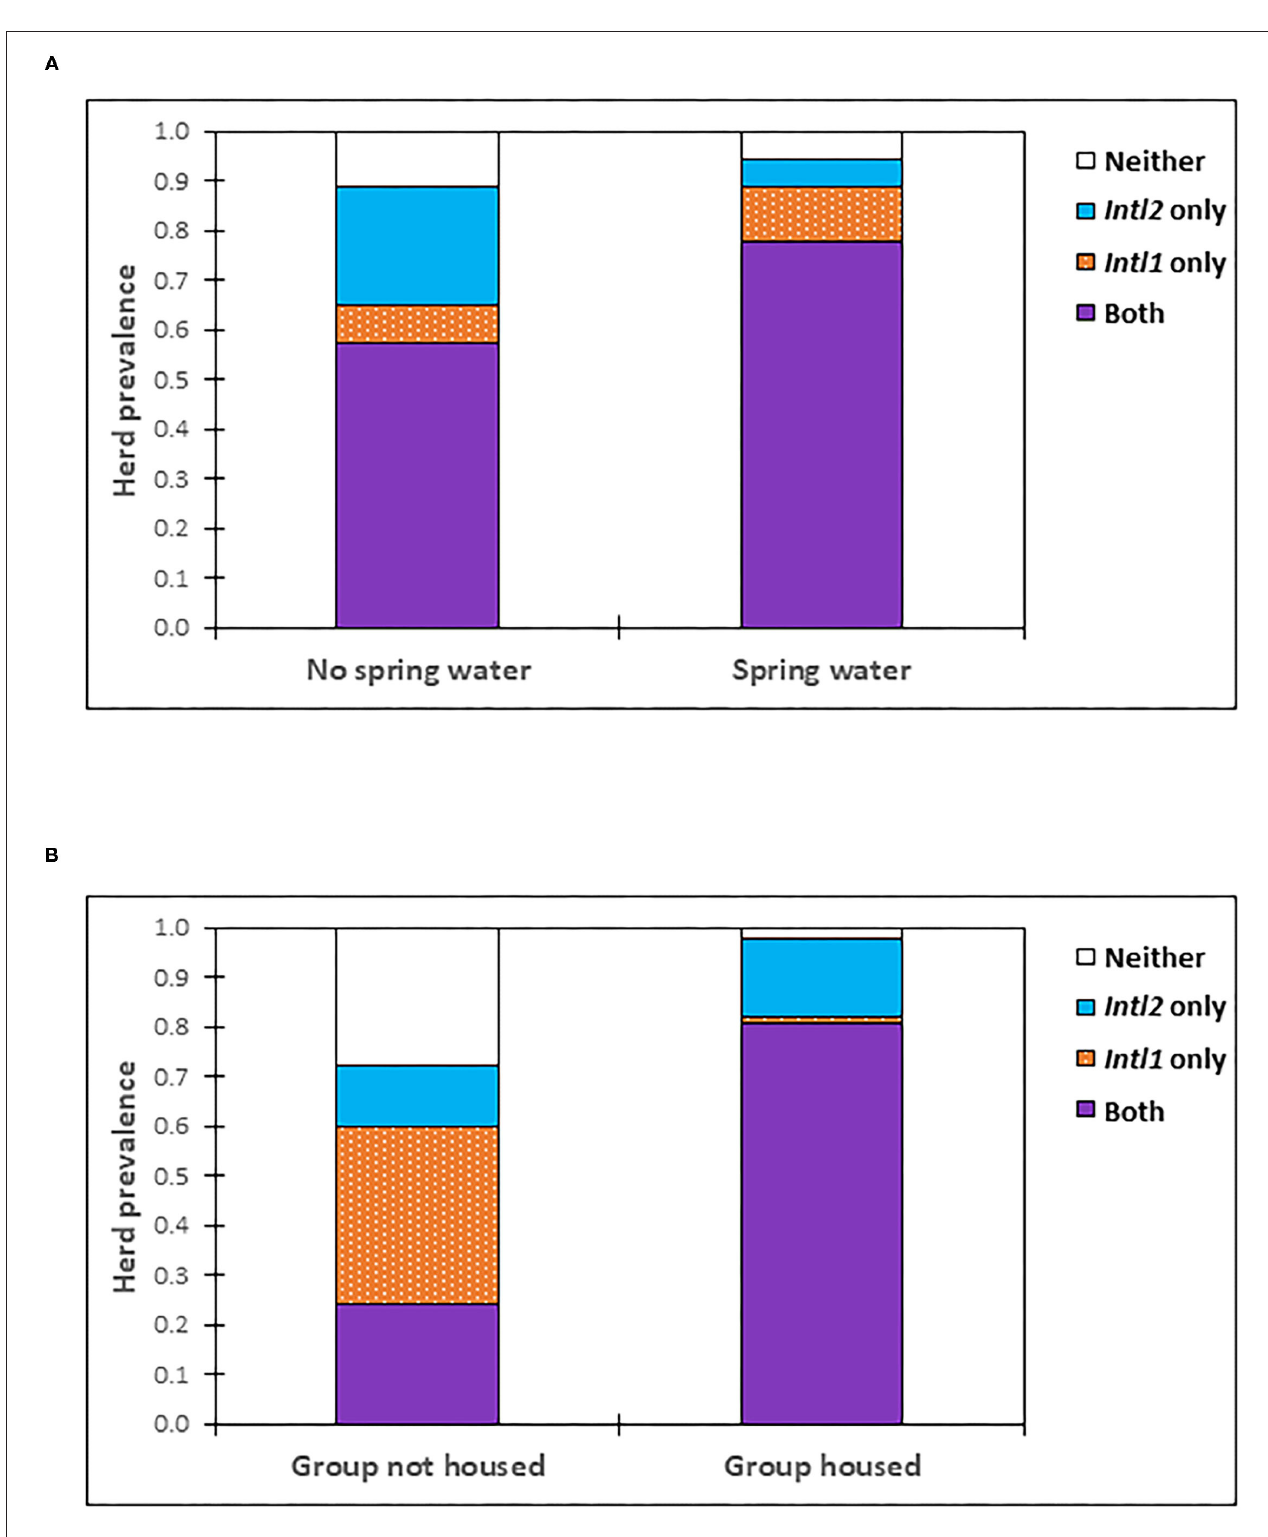
FIGURE 2 | Prevalence of herds positive for intI1 and/or intI2 by (A) whether cattle are watered from a natural spring source, or not and (B) whether cattle are housed/not housed i.e., grazed, at the time of sampling.